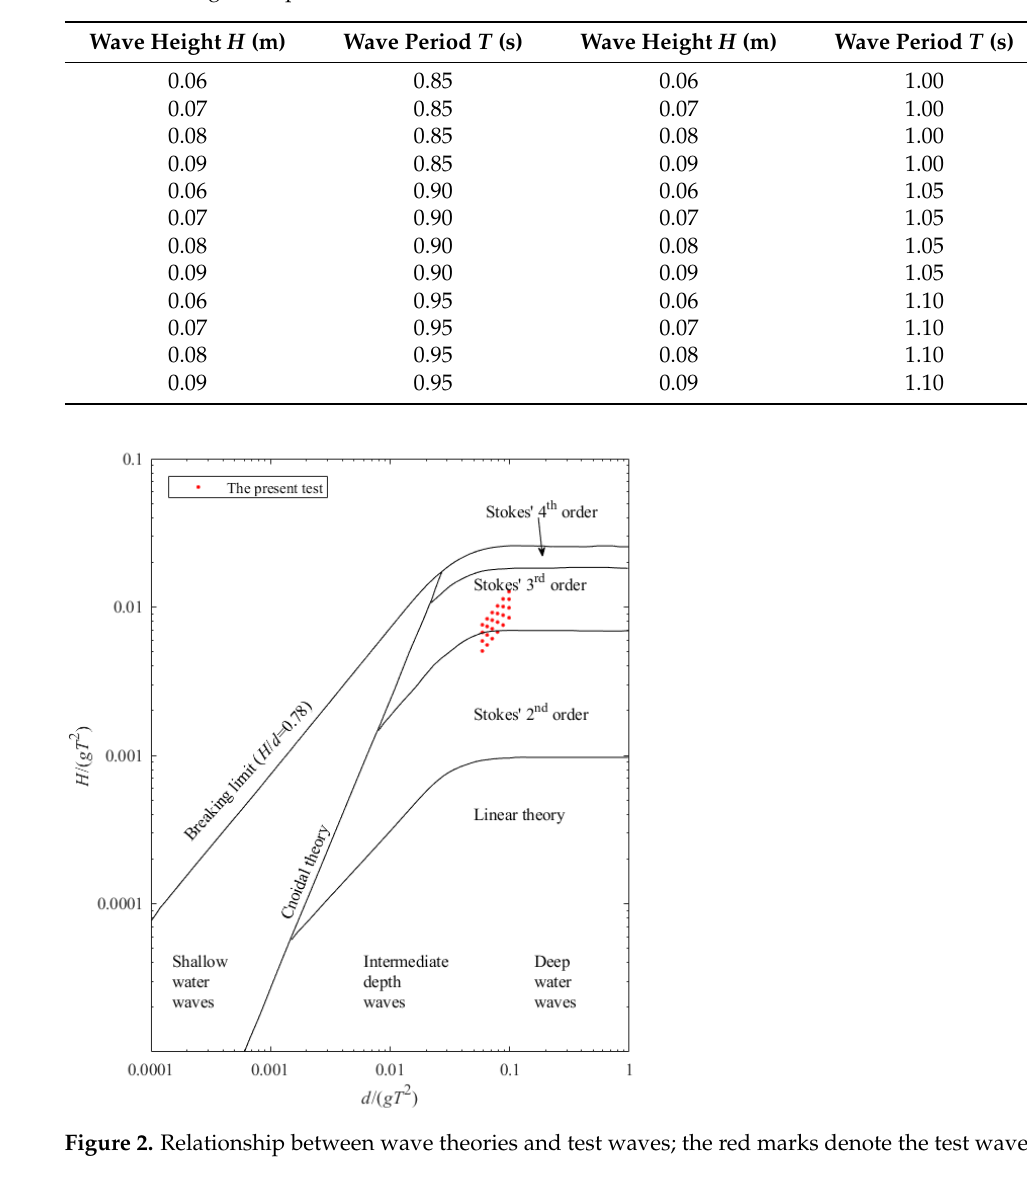
Table 1. Testing wave parameters.